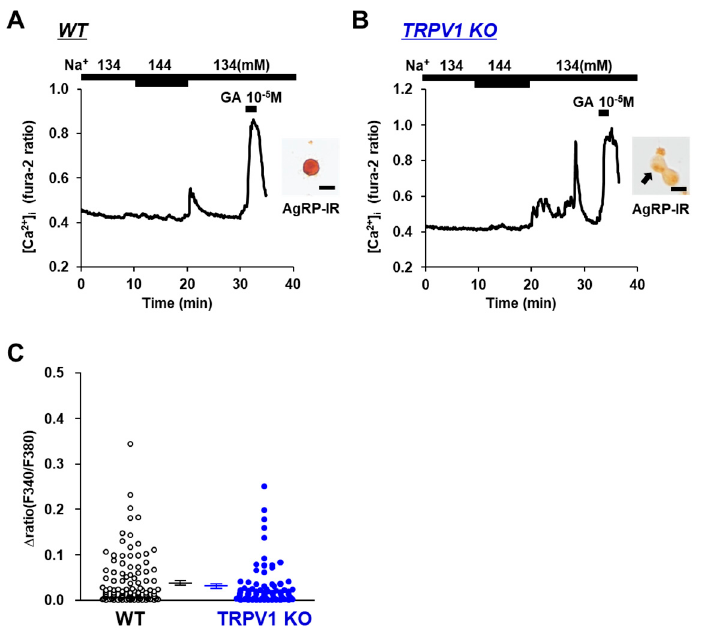
Figure 3. Increased extracellular [Na + ] increased [Ca 2+ ] i in single AgRP neurons from TRPV1 KO mice. ( A , B ) Typical example of [Ca 2+ ] i responses to [Na + ] increase and 10 − 5 M glutamate (GA) in AgRP neurons from wild-type mice ( A ) and TRPV1 KO mice ( B ). Scale bar is 20 μ m. ( C ) Average amplitude of [Ca 2+ ] i responses to increased extracellular [Na + ] ( Δ ratio) in AgRP neurons. Data are presented as mean ± SEM. WT vs. KO determined by one-way ANOVA followed by the Bonferroni test.